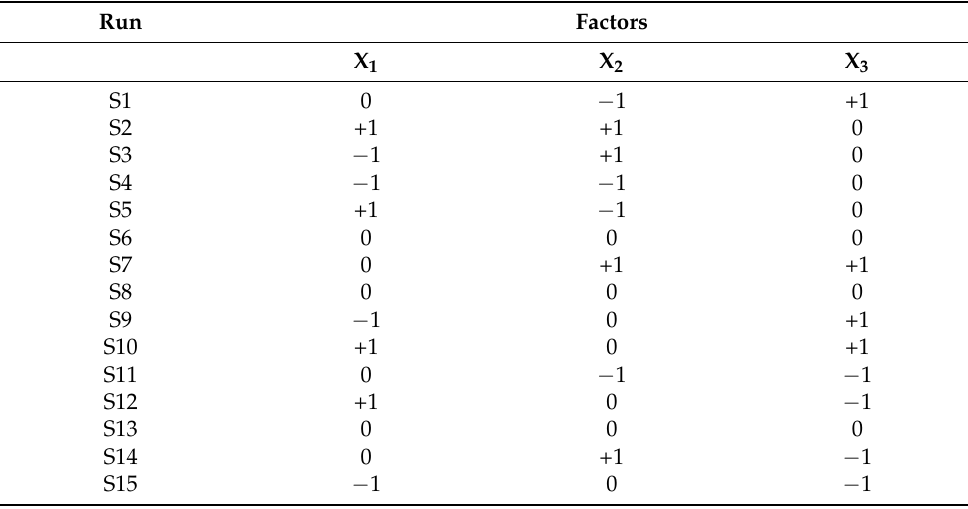
Table 2. 15-run experimental designs from Box–Behnken